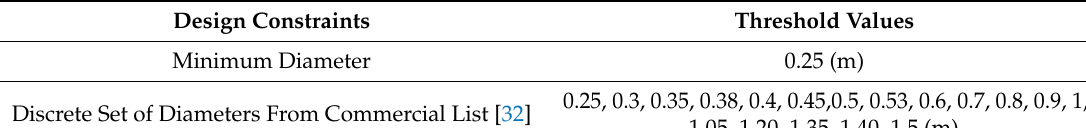
Table 2. Hydraulic design constraints used in this study, modified from Austrian guideline